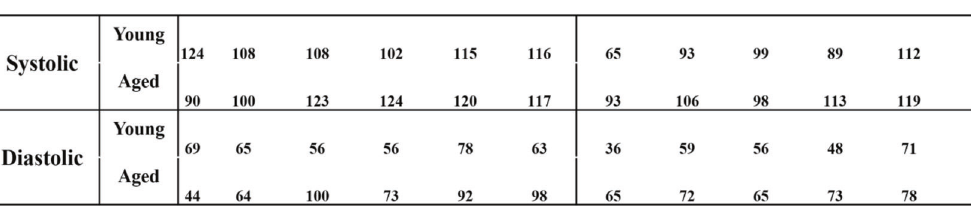
Fig. 2 Reduced cardiac microvascular density in the myocardium of MAP4 KI mice. A Representative confocal images of CD31 in the myocardium. Scale bar, 10 µm; n = 3. Yellow arrows point to capillary. B Representative confocal images of lectin in the myocardium. Scale bar, 10 µm; n = 3. C A scatter diagram showing the statistical analysis of microvascular density in myocardium stained with CD31. N.S. represents no statistical difference between the Con-young and MAP4 KI-young groups. ** p < 0.01 versus the Con-young group; ### p < 0.001 versus the Con-aged group. D A scatter diagram showing the statistical analysis of red circles in myocardium stained with lectin. ** p < 0.01 versus the Con-young group; ### p < 0.001 versus the Con-aged group. E In vivo blood pressure measurement of WT and MAP4 KI mice at different ages. F Statistical analysis of Systolic pressure in ( A ). N.S. represents no statistical difference; n = 6. G Statistical analysis of Diastolic pressure in ( A ). N.S. represents no statistical difference; n = 6. Cell Death Discovery (2021)